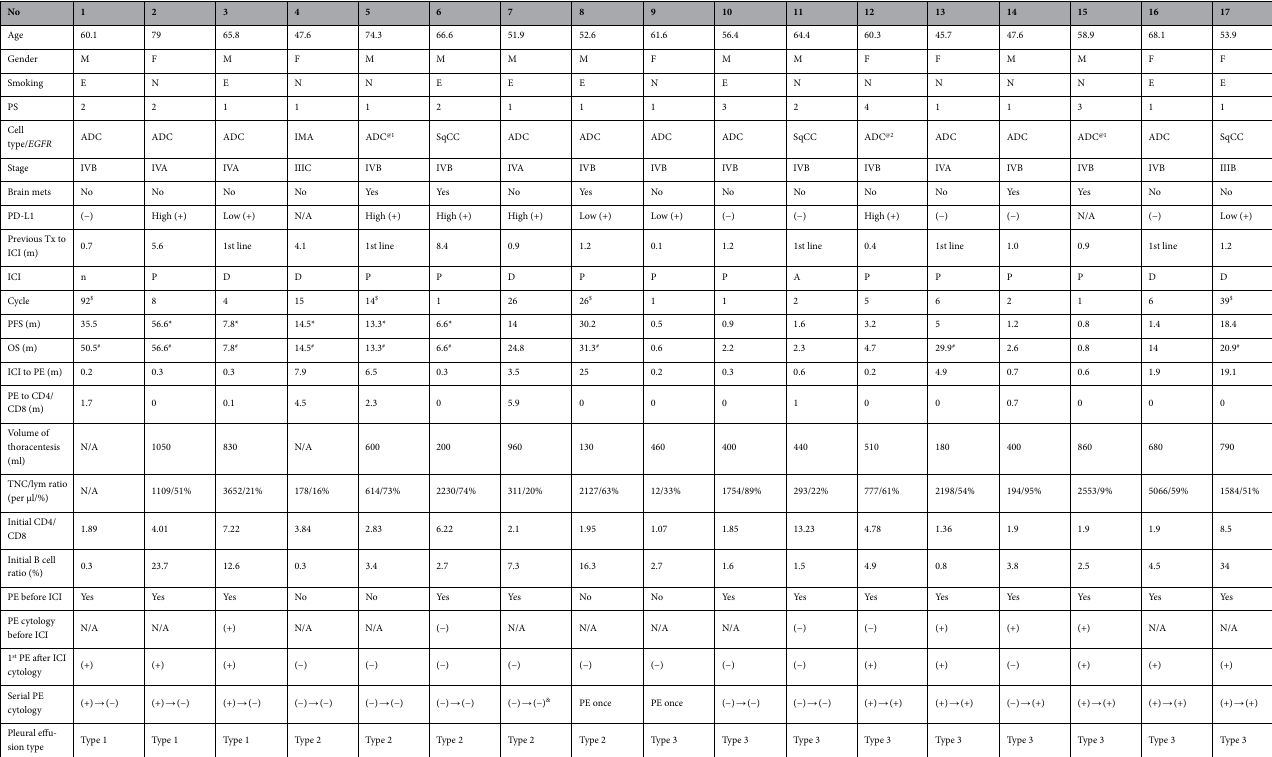
Table 2. Clinical data and outcomes of lung cancer patients developing pleural effusion after ICI use. ICI, immune checkpoint inhibitor; M, male; F, female; E, ever smoker; N, never smoker; PS, Eastern